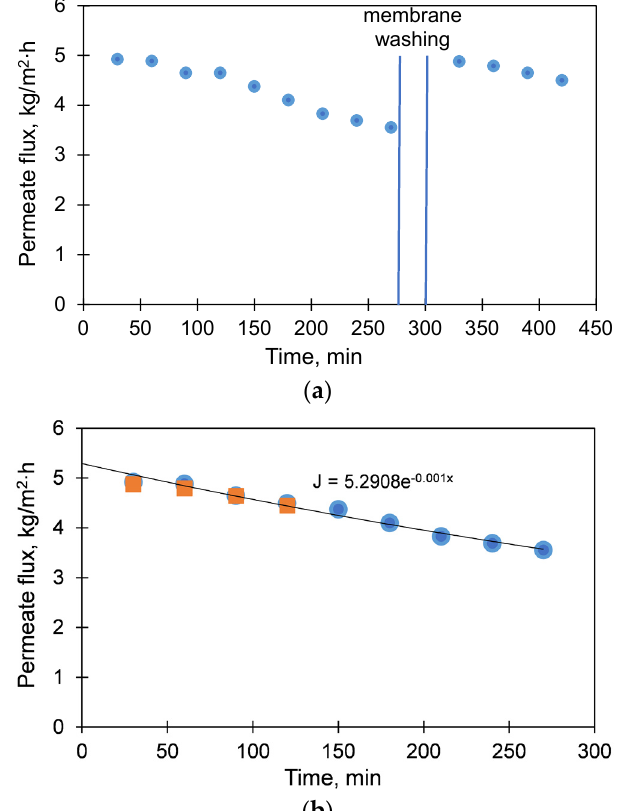
Figure 4. Experimental permeate fluxes in AGMD-MC module: ( a ) decrease of permeate flux before (blue dots) and after (orange squares) membrane washing; ( b ) exponential approximation of the permeate flux, using data obtained before (blue dots) and after (orange squares) membrane washing. Initial feed concentration 10 wt.% NaCl, hot circuit temperature 60 ◦ C, cold circuit temperature 20 ◦ C, d = 3 mm.